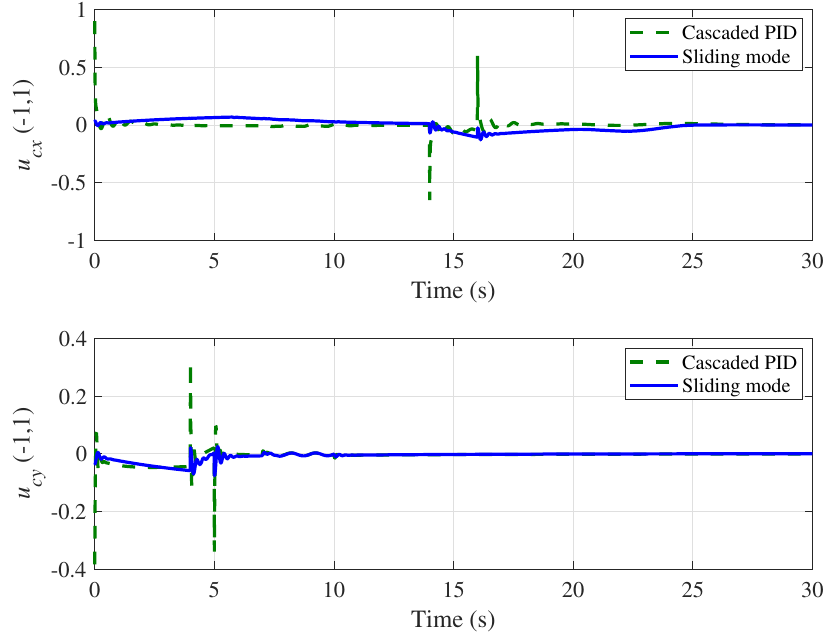
Figure 12. Normalized control inputs of azimuth axis and elevation axis in numerical